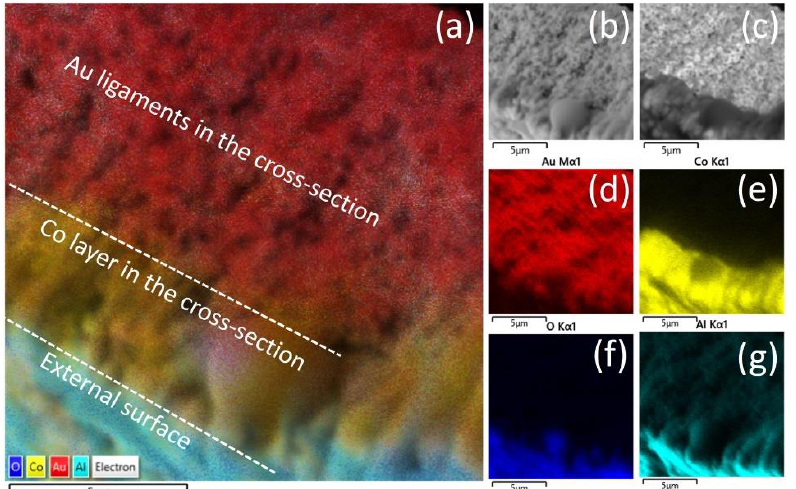
Figure 6. ( a ) Layered compositional map depicting Au, Co, O and Al content of the sample Co- NPG_195; ( b ) SE-SEM image, ( c ) BS-SEM image; ( d ) map showing only Au content; ( e ) map showing only Co content; ( f ) map showing only O content; and ( g ) map showing only Al content.